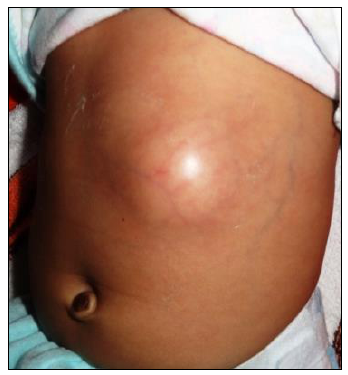
Figure 1: Case 1- presenting with inflammatory swelling in the left upper abdomen.